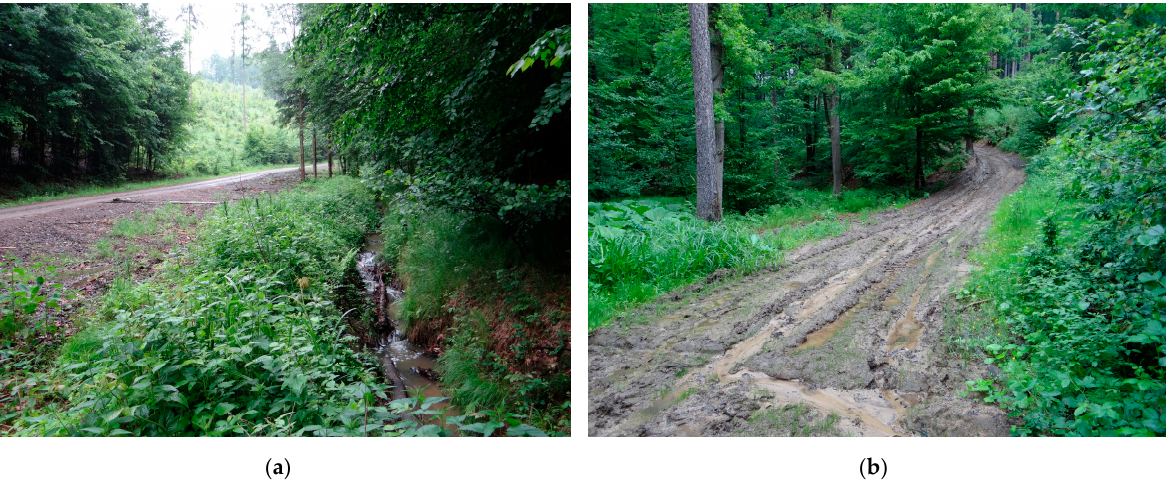
Figure 10. Forest engineering structures serving forest management in habitats of C. heros : ( a ) main forest road in the first category; ( b ) tractor logging road.